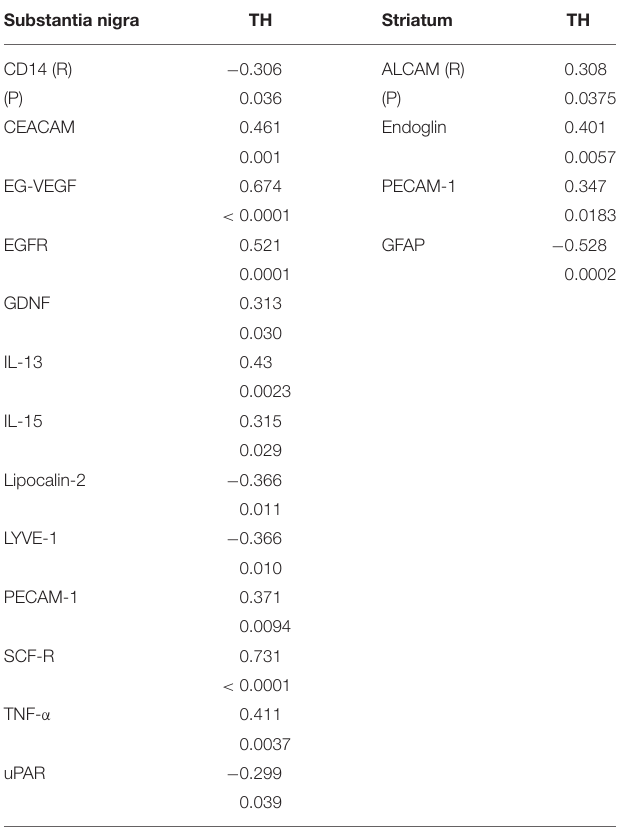
TABLE 7 | Significant Correlations between protein measures and